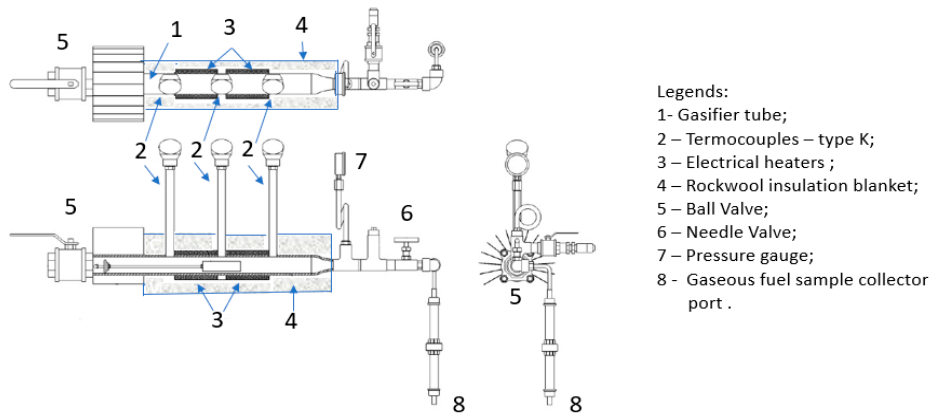
Figure 1. The POLICOM bench-scale gasifier scheme (adapted from Reference [34]).